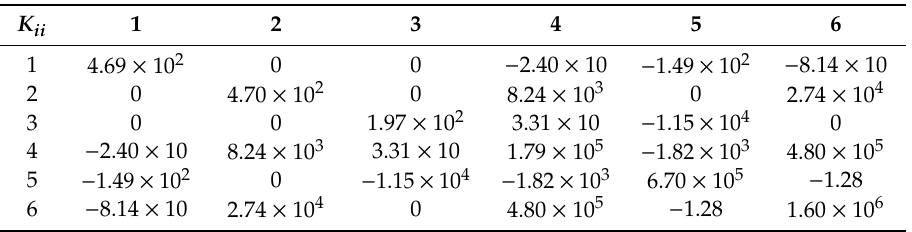
Table 8. External sti ff ness values considered in the WAMIT code analysis in the full scale ( i -index is the corresponding DOF as, 1 = surge (kN / m), 2 = sway (kN / m), 3 = heave (kN / m), 4 = roll (kN.m / rad), 5 = pitch (kN.m / rad), and 6 = yaw (kN.m / rad)).